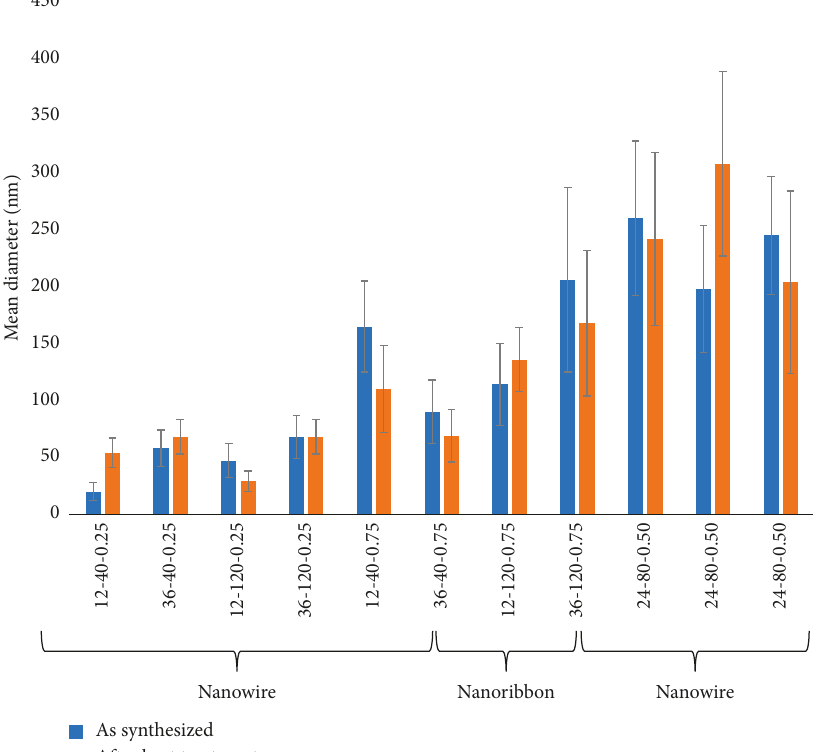
Figure 4: Morphology, mean diameter, and standard deviation for each of synthesis conditions, as synthesized, and after heat